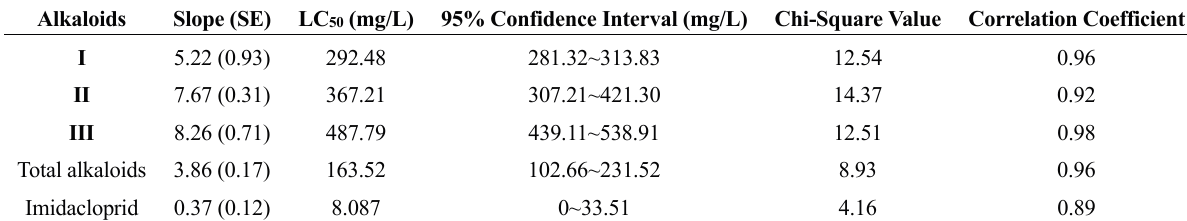
Table 1. Toxicity of C. mongolicum alkaloids against wingless adult aphids Lipaphis erysimi .